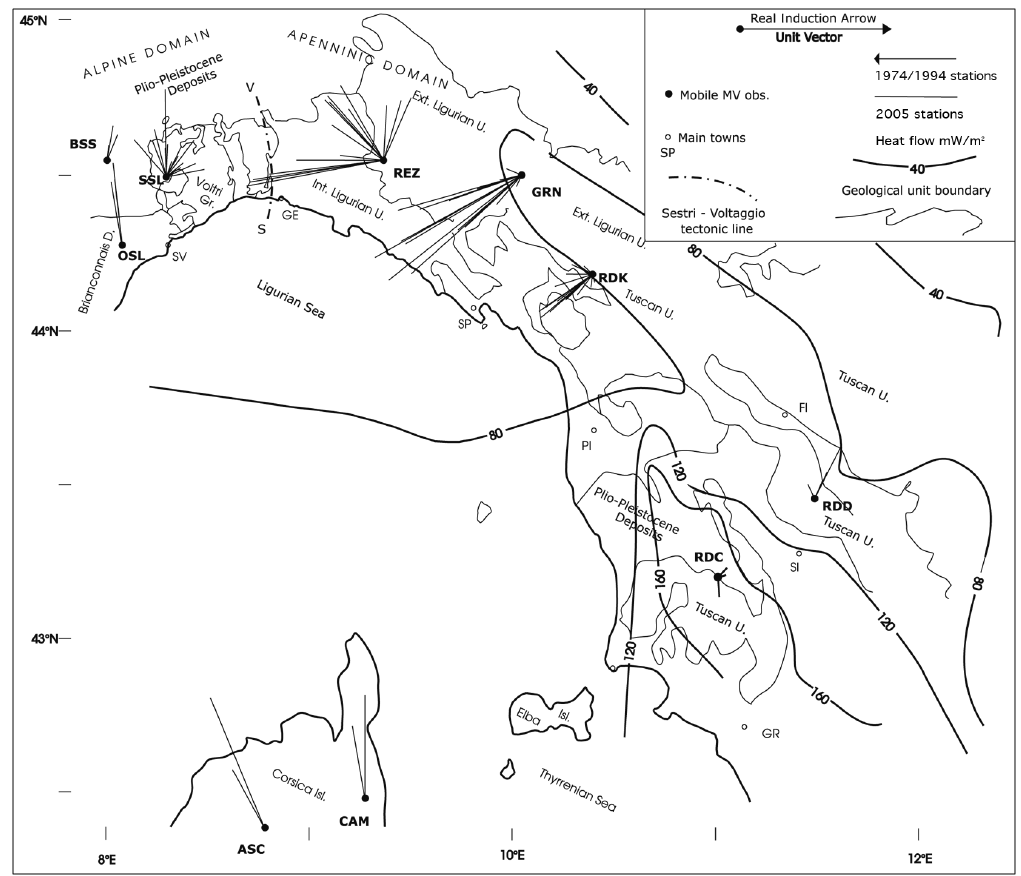
Fig. 1. Geological setting and magnetovariational array; S-V: Sestri Voltaggio tectonic boundary; short arrows do not have pointers; previous surveys data have been displayed with filled line